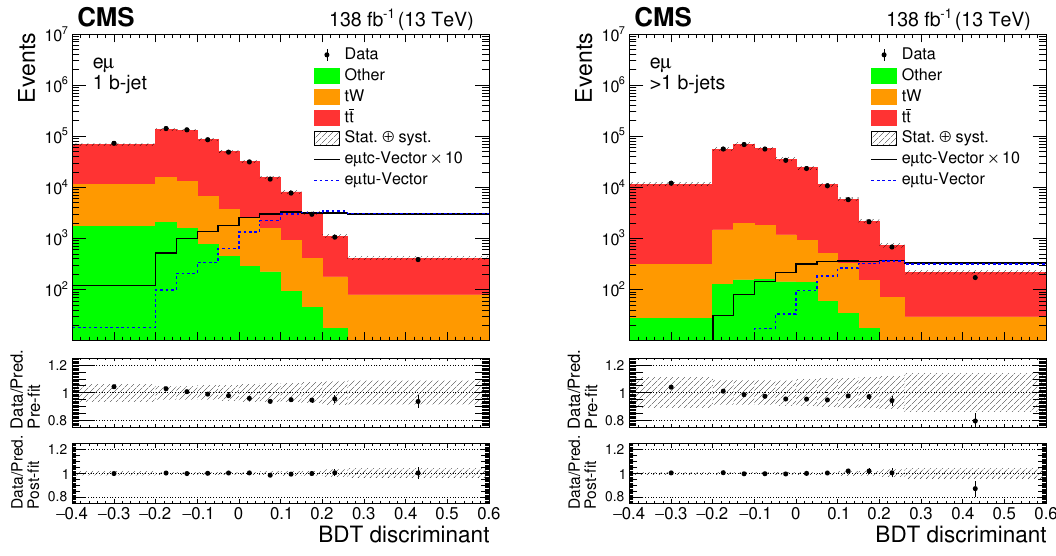
Figure 4 . The BDT output distributions for data (points) and backgrounds (histograms) with the ratio of data to the total background yield, before (middle panel) and after (lower panel) the fit. Events in the signal region (one b tagged jet) and tt control region (more than one b tagged jets) are shown in the left and right column, respectively. The hatched bands indicate the total uncertainty (statistical and systematic taken in quadrature) for the SM background predictions (cf. section 6). Examples of the predicted signal contribution for the vector type CLFV interactions via e m tu and e m tc vertices are shown, assuming C / Λ 2 = 1 TeV − 2 . The signal production- and x decay-mode contributions are summed. The e m tc signal cross section is scaled up by a factor of 10 for improved